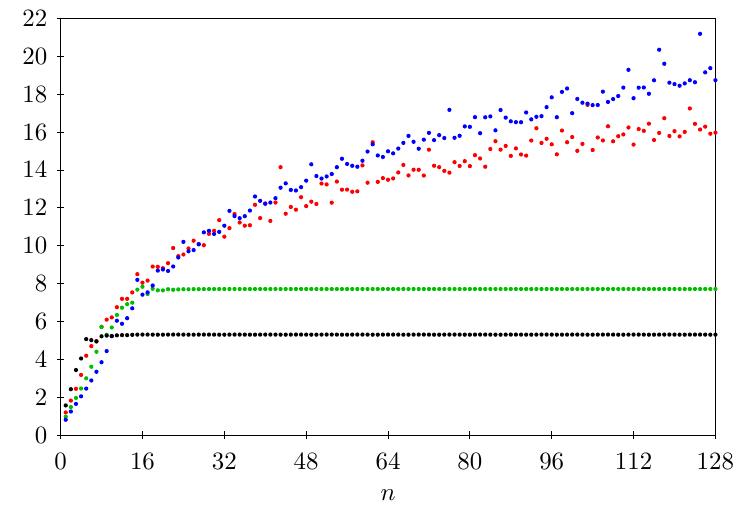
Figure 9 . The gaps log (1 / | ∆ n ( c ) − ( n + ( c − 4) / 8) | ) for c = 16 (black), c = 20 (red), c = 24 10 (green), and c = 28